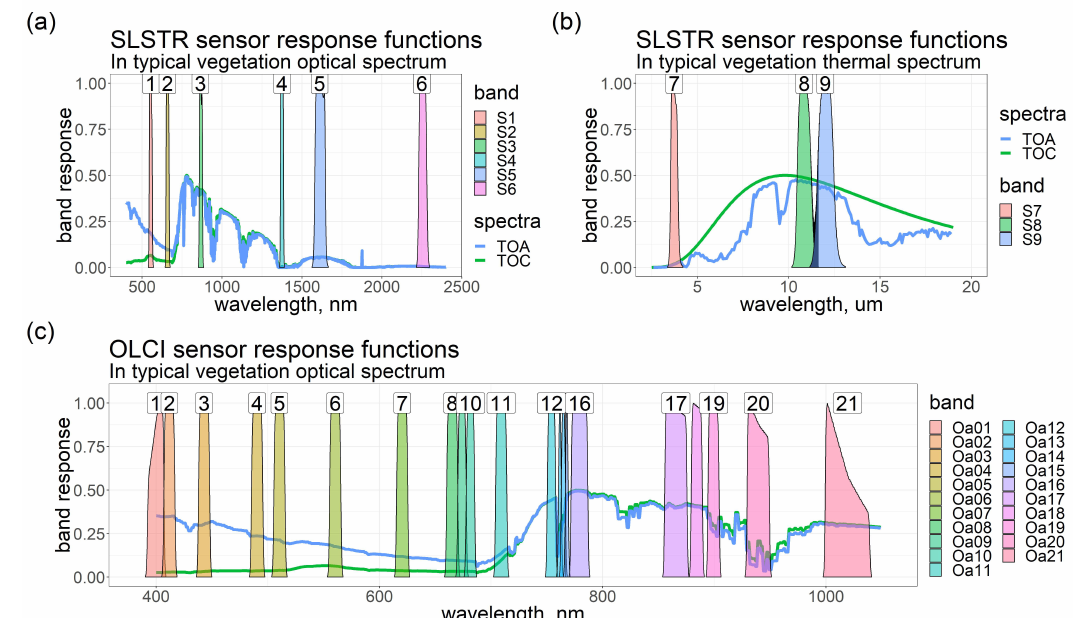
Figure 1. Sensor response functions of Sentinel-3 satellite instruments in typical vegetation top of canopy (TOC, green) and top of atmosphere (TOA, blue) radiance spectra. ( a )—optical Sea and Land Surface Temperature Radiometer (SLSTR); ( b )—thermal SLSTR; ( c )—Ocean and Land Colour Imager